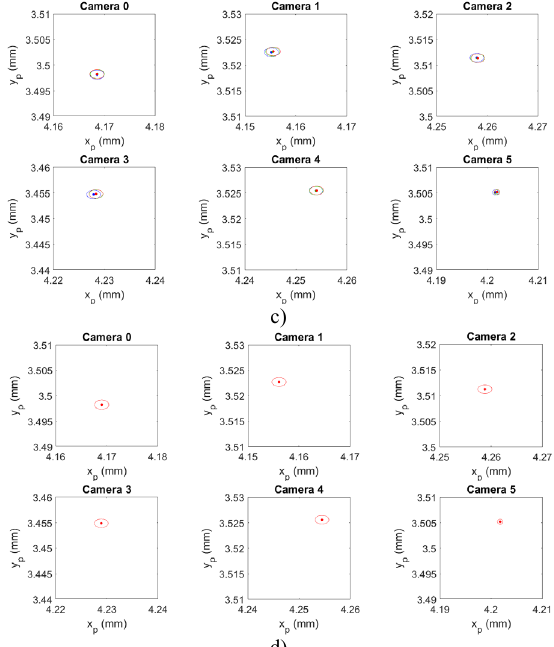
Figure 6. Ladybug5 principal point and 95% confidence region for a) Case 1, b) Case 2, c) Case 3, d) Case 4.